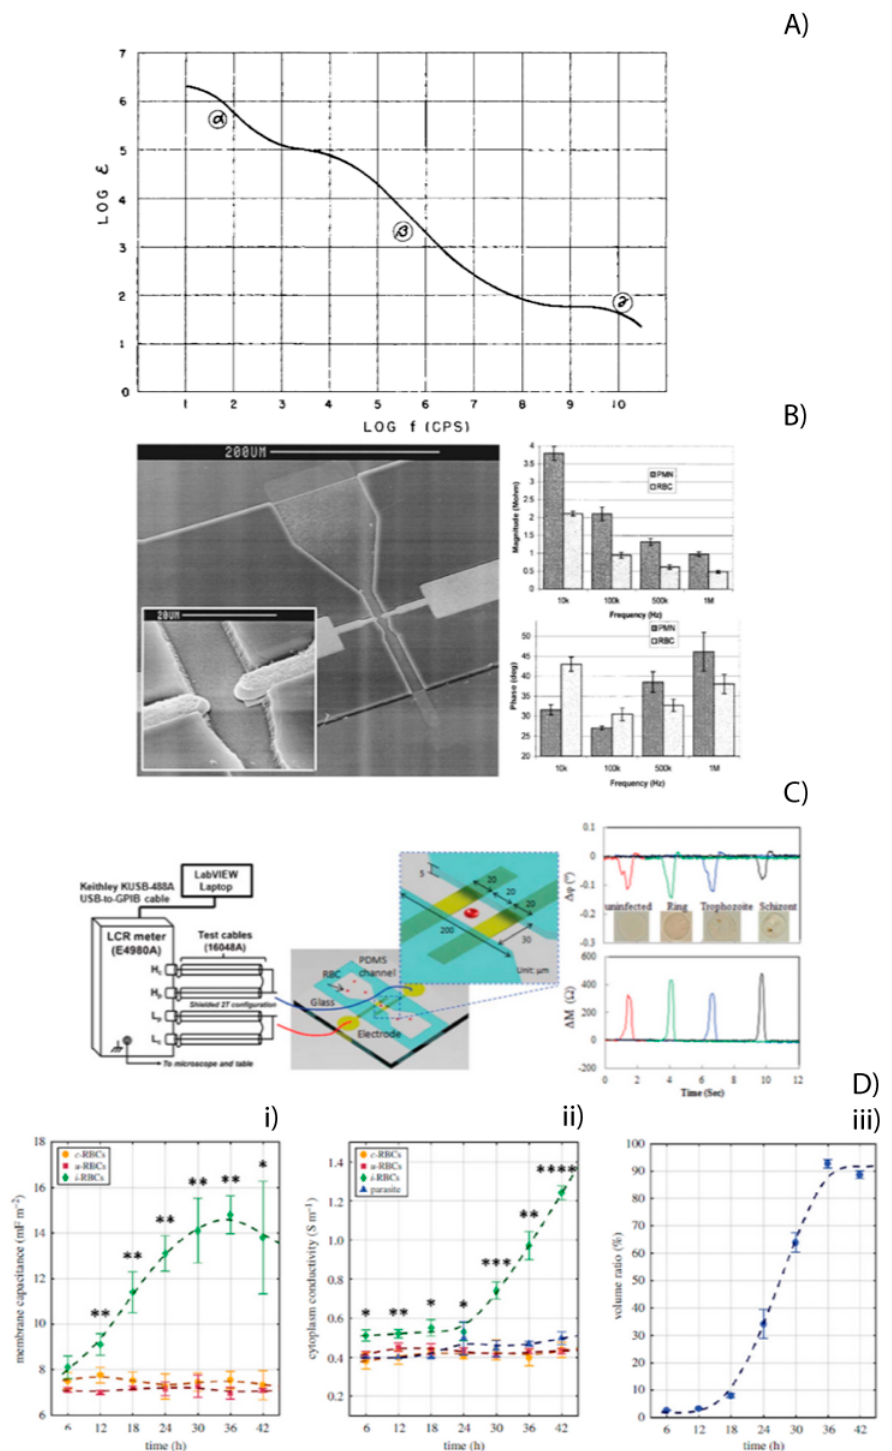
Figure 5. ( A ) The dielectric constant of muscular tissue as a function of frequency decreases in three major steps. The three steps are identified as a-, ß-, and 7-dispersion. Reprinted with permission from ref. [63] © 1957 ACADEMIC PRESS INC. Published by Elsevier Inc. ( B ) Electron scanning image of the channel and electrodes (Left). Magnitude and phase of the impedance values at different frequencies for PMN’s and RBC’s (Right). Reprinted with permission from ref. [66] © 1999 IEEE Journal of Microelectromechanical Systems . ( C ) Experimental MIFC system setup for Pf-iRBC detection using a microfluidic device (Left). EI transitions measured as uninfected RBCs and Pf-iRBCs crossed